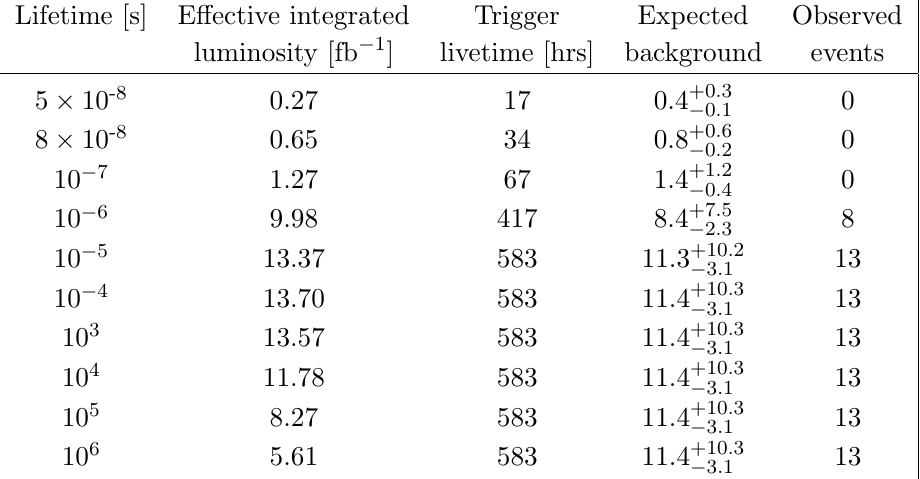
Counting experiment results for di(cid:11)erent lifetimes in the calorimeter search with 2016